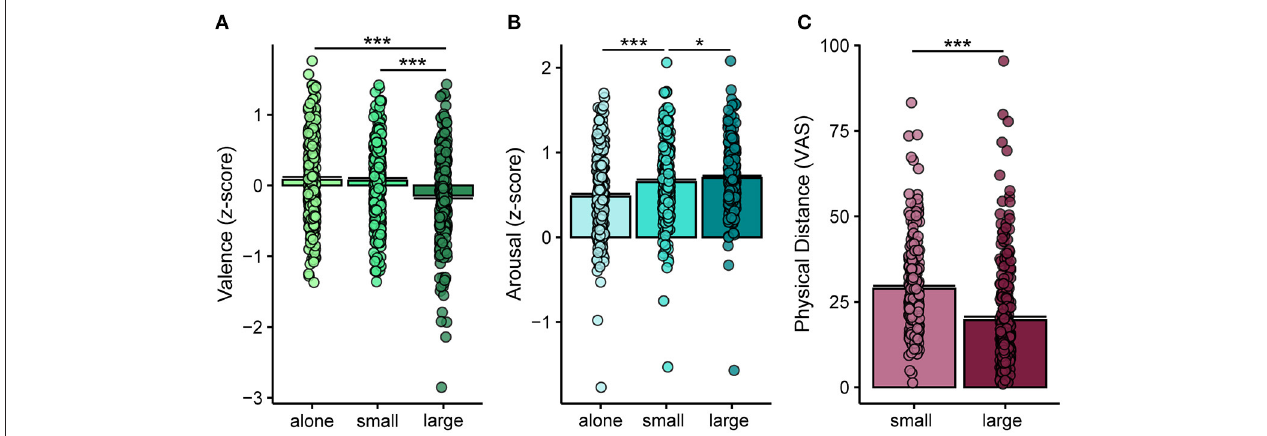
FIGURE 2 | Mean ratings of (A) valence, (B) arousal, and (C) perceived physical distance. Ratings of valence and arousal were normalized by the average ratings provided by another group of participants collected before the COVID-19 pandemic (Kurdi et al., 2017). Perceived physical distance was only recorded in this study, and only in response to images depicting more than one person. Bars represent standard error of the mean; points represent individual means; asterisks indicate significant differences between conditions (* p < 0.05; *** p < 0.001).